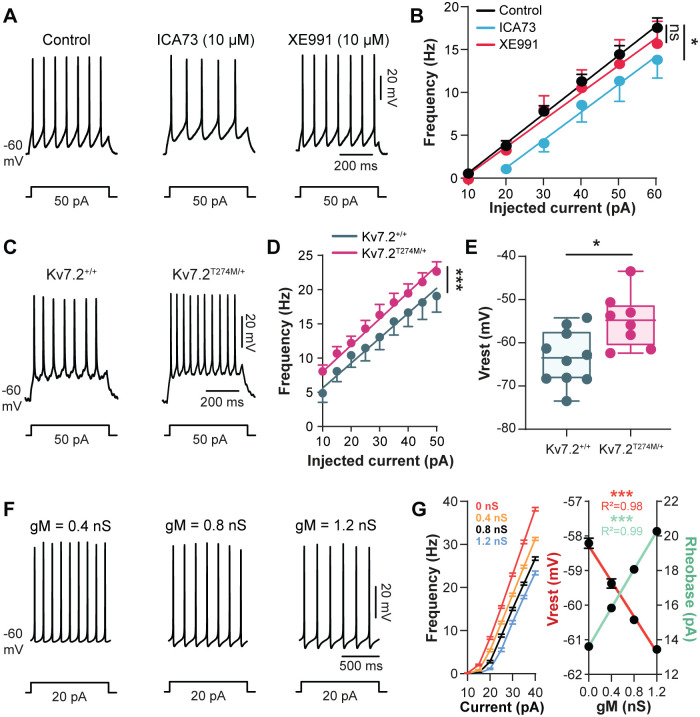
IM mediated by Kv7.2-containing channels regulates both the excitability and the spiking activity of L1–L2 ventromedial interneurons.(A,B) Spiking activity of ventromedial interneurons (L1–L2) to a near-threshold depolarizing pulse (A) with its respective frequency–current relationships (B) before (black) and after bath-applying ICA73 (10 μM, n = 7 cells, blue) or XE991 (10 μM, n = 7 cells, red). Continuous lines represent the best-fitting linear regression. ***P < 0.001 comparison of the fits before and after adding the abovementioned drugs. (C–E) Representative spiking activity (C), frequency–current relationships (D), and resting membrane potential (E) of ventromedial interneurons (L1–L2) recorded from wild-type (n = 10 cells) and Kv7.2Thr274Met/+ mutant mice (n = 8 cells). Continuous lines represent the best-fitting linear regression. ***P < 0.001 comparison of the fits. *P < 0.05, comparing resting membrane potentials; Mann–Whitney test. (F) Spiking activity from a single-neuron model at 3 different values of gM. The injected current pulses in A, C, and F are indicated below voltage traces. (G) Mean plots of the firing rate, rheobase, and resting membrane potential as function of gM (in the heterogeneous population model of 50 neurons). The continuous line is the best-fitting linear regression. ***P < 0.001, Spearman correlation test. R2 indicates the correlation index. Data are mean ± SEM. Underlying numerical values can be found in the S1 Data. ICA73, N-(2-chloro-5-pyrimidinyl)-3,4-diflurobenzamide; XE991, 10,10-bis(4-pyridinylmethyl)-9(10H)-anthracenone dihydrochloride.